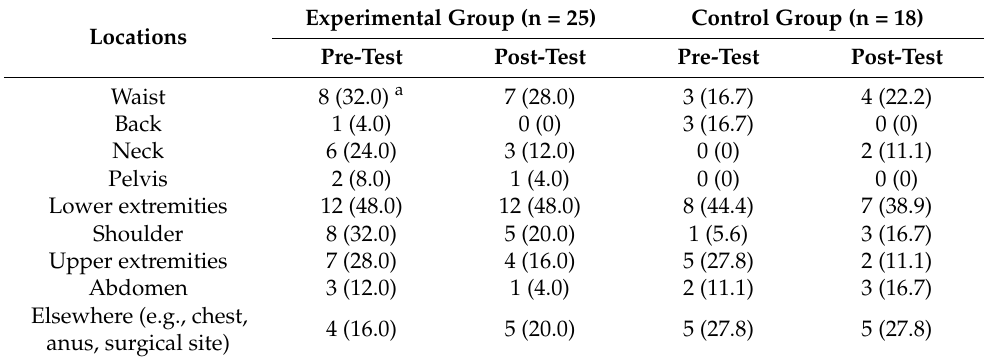
Table 2. Locations of pain.